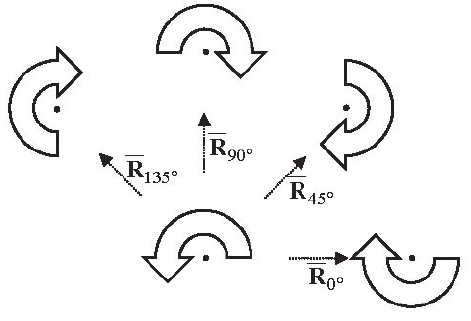
Figure 8 Some reflectional magnifications. Note that the an - ticlockwise sense of the arrow in the object is reversed in the